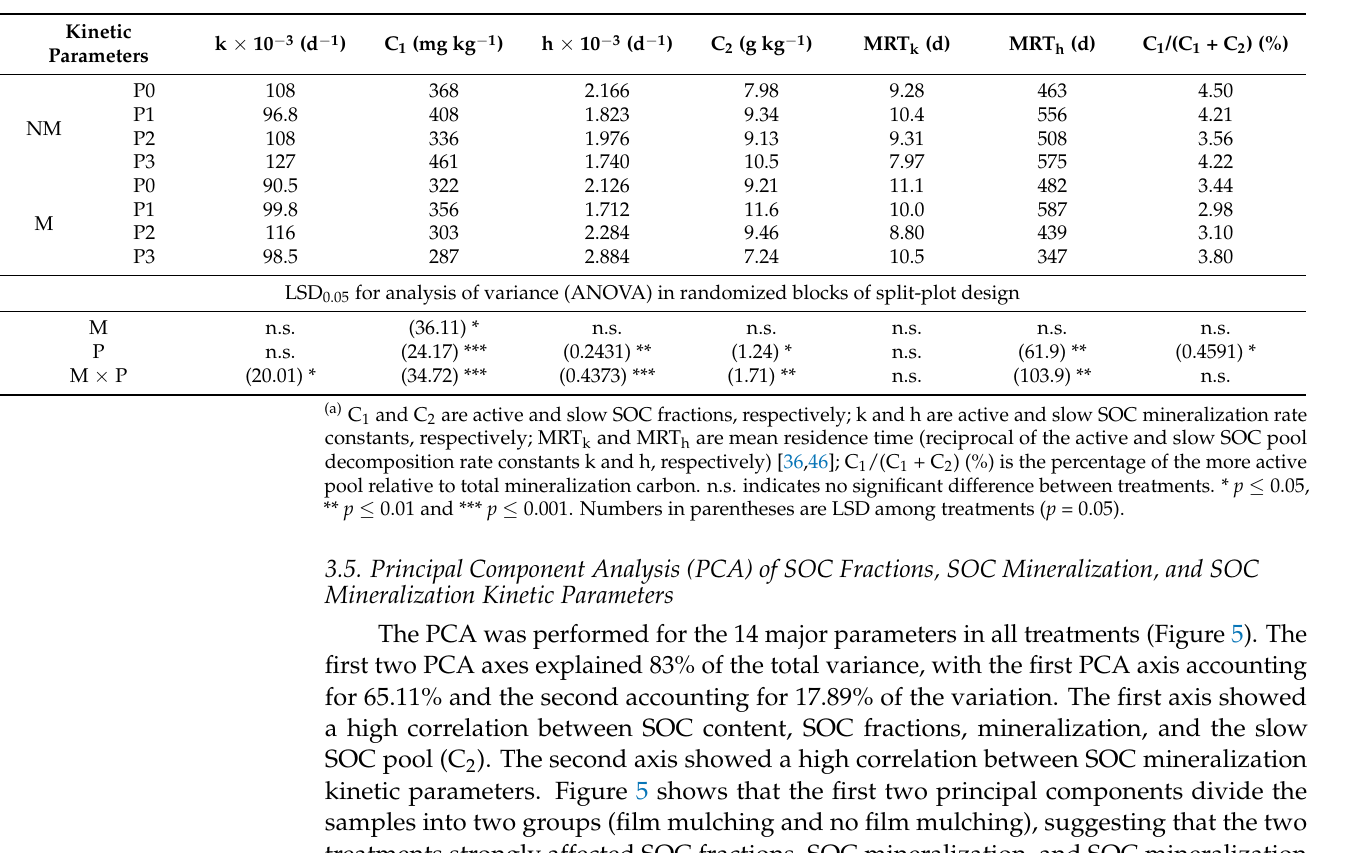
Table 3. SOC mineralization kinetic parameters (a) obtained from the model C t = C 1 (1 − e − kt ) + C 2 (1 − e − ht